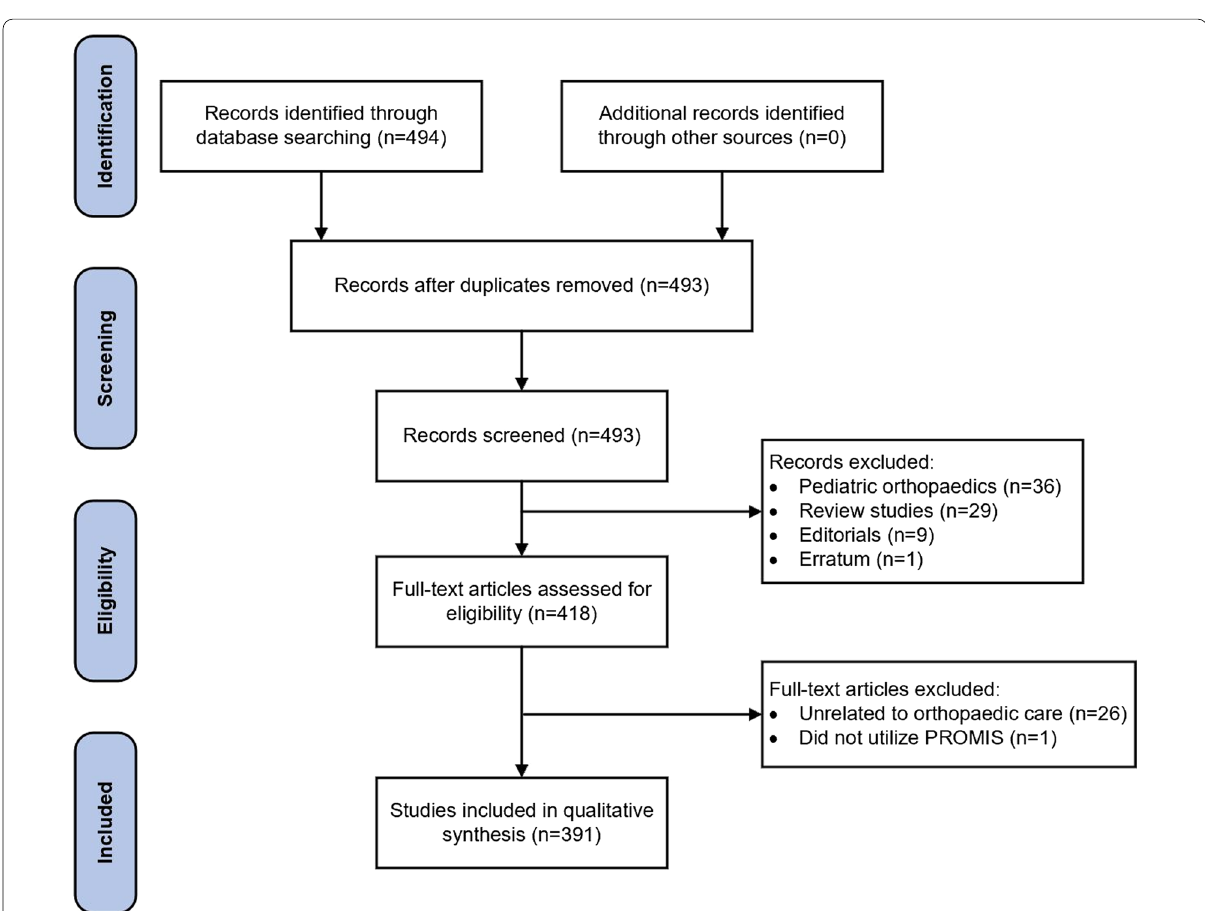
Fig. 1 The preferred reporting items for systematic reviews of meta-analyses flow diagram for Patient-Reported Outcomes Information System (PROMIS) publications in adult orthopaedic surgery